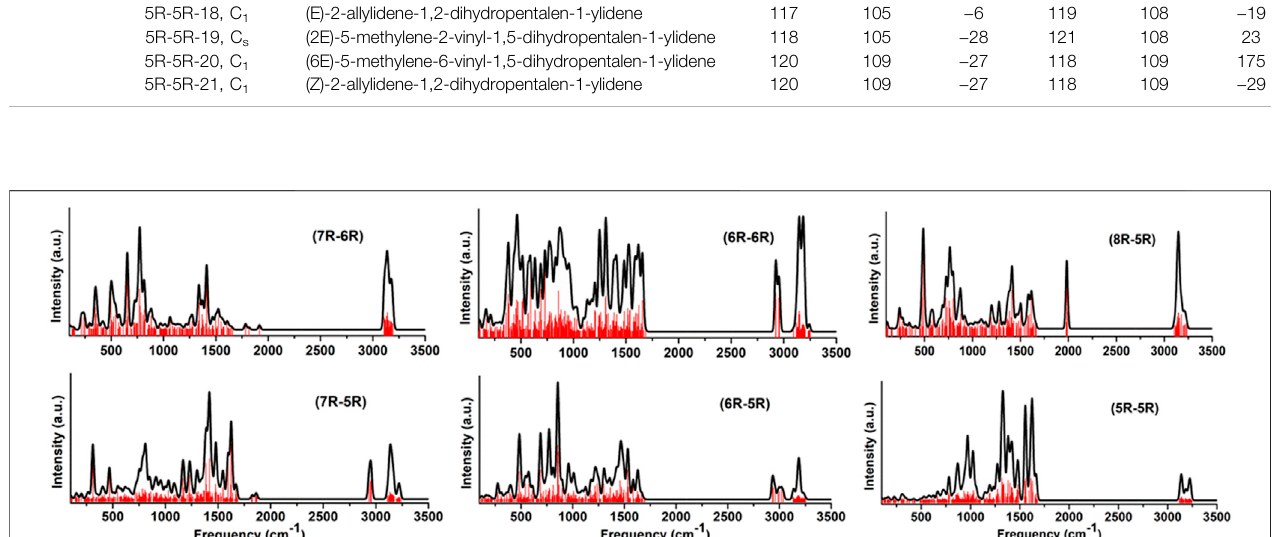
Frontiers in Physics |